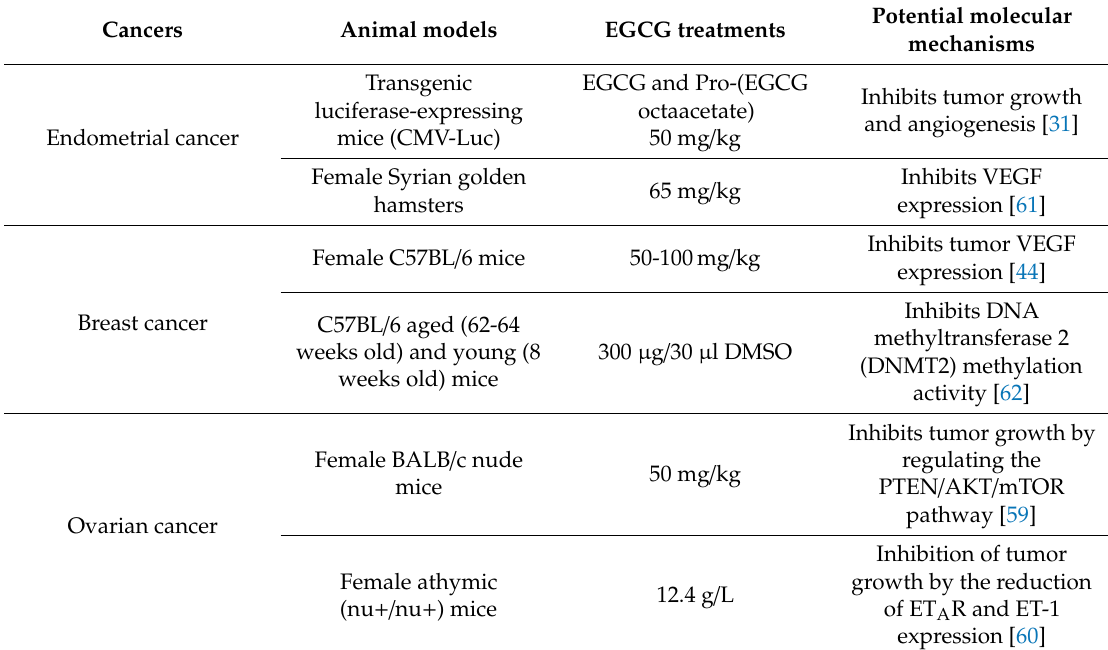
Table 2. Anticancer e ff ects of EGCG based on animal